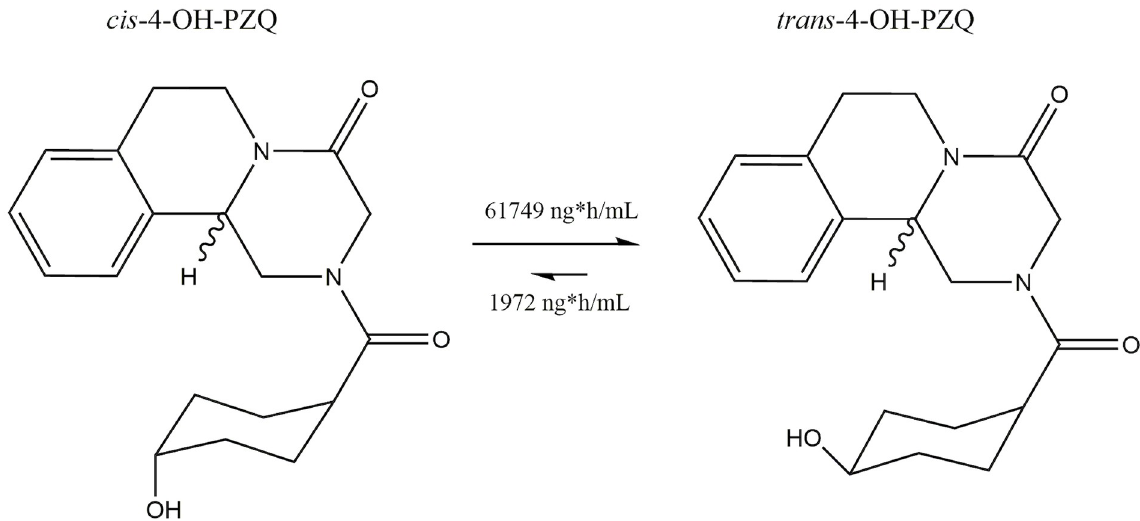
Fig 8. The favourable formation of trans -4-OH-PZQ compared to the cis -4-OH-PZQ isomer created from pharmacokinetic data by Nleya and colleagues [84]. The equatorial position points upwards and the axial position points downwards. The chemical structures were created using ChemDraw Prime v16.0. PZQ,